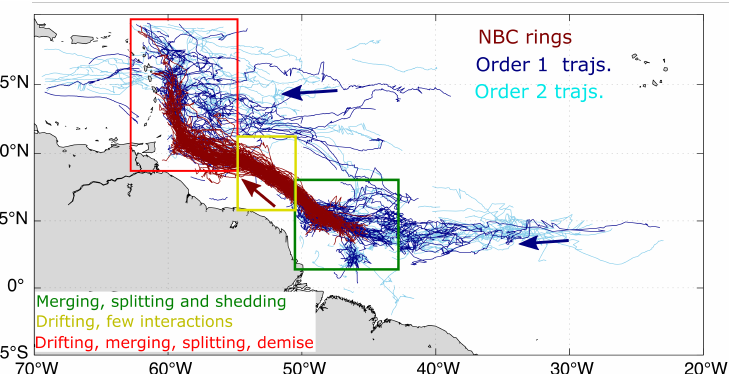
Figure 16. Network associated with NBC rings (in dark red). Order 1 trajectories are in dark blue and represent eddies that merged (split) with (from) NBC rings. Order 2 trajectories are in cyan and represent eddies that merged (split) with (from) eddies that interacted directly with NBC